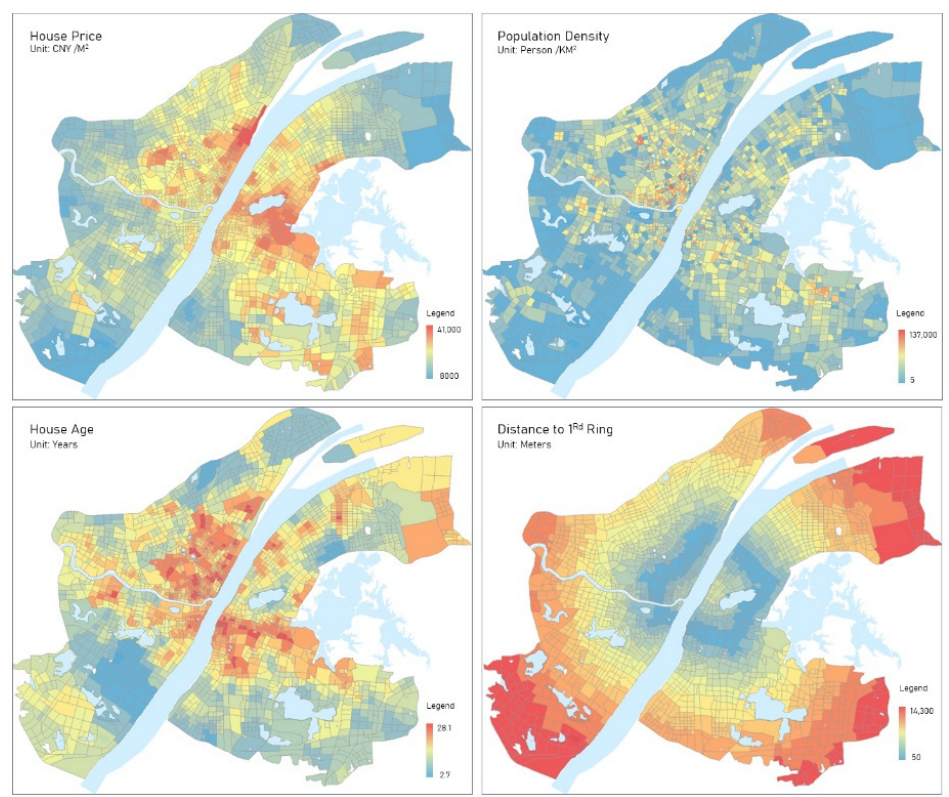
Figure 3. Mapping Variables of Housing prices and other control variables.